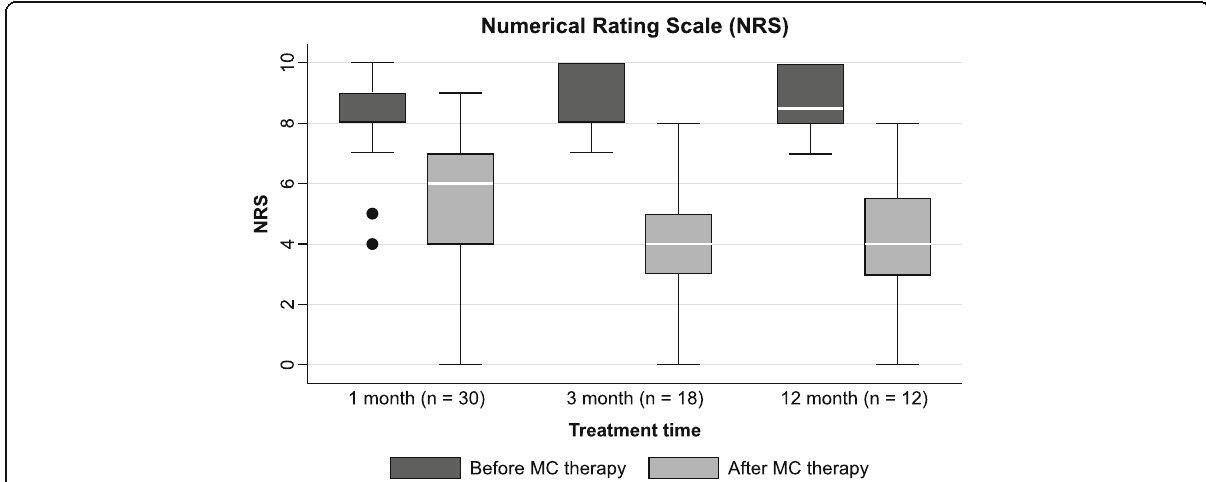
Fig. 3 Numerical Rating Scale at 1, 3, and 12 months. NRS boxplots before and after MC therapy at 1, 3, and 12 months. Statistically significant improvements were registered for comparisons at 1, 3, and 12 months ( P < 0.01). The boxes contain the middle 50% of the values; the thick white lines indicate the median; the whiskers connected by dashed lines to the boxes mark the minimum and maximum values except when there are outliners, which are specifically indicated by circles. NRS Numerical Rating Scale, MC medical